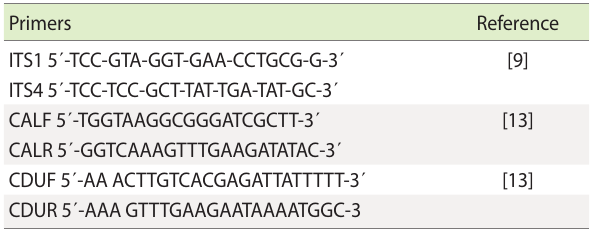
Table 1. List of primers used in this study